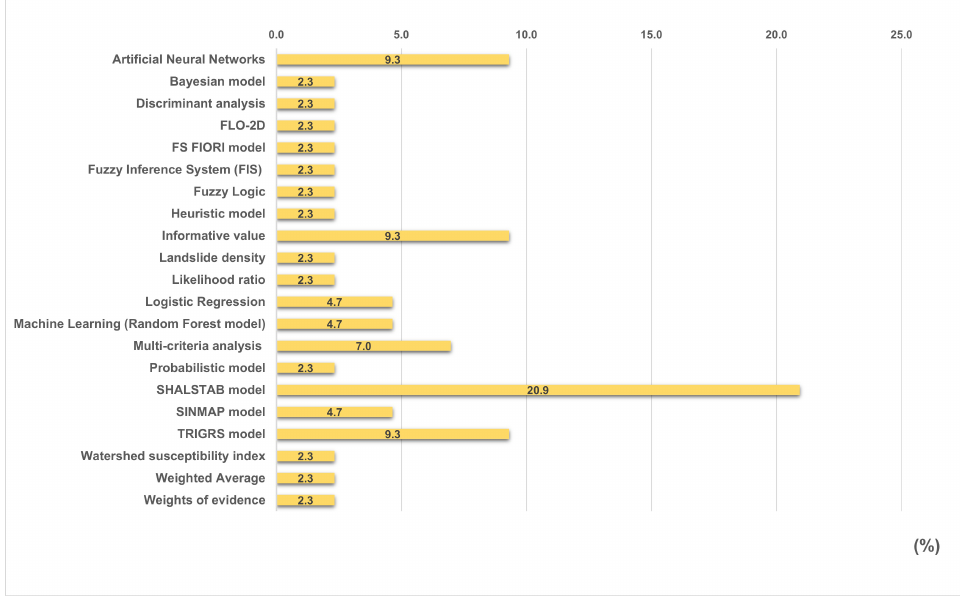
Figure 6. Susceptibility model types used most frequently in Brazil. SHALSTAB is the most common model with 20.9% of the studies using